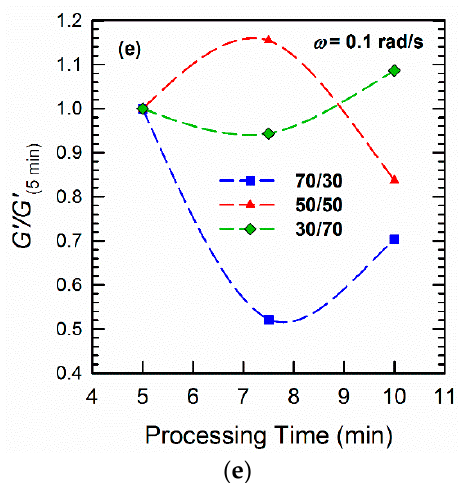
Figure 1. Storage moduli G ′ ( ω ) of ( a ) neat polymers and ( b ) 70/30, ( c ) 50/50, and ( d ) 30/70 PLA/PVDF blends processed for different times as a function of frequency from 0.01 to 100 rad/s at strain amplitude of 0.5% and a temperature of 200 °C under a nitrogen atmosphere; ( e ) storage moduli of the blends normalized relative to the storage moduli of the blends processed for 5 min at a fixed frequency of 0.1 rad/s.